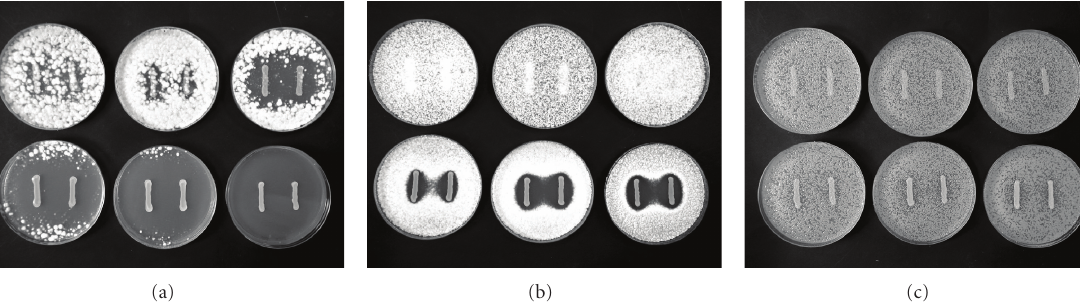
Figure 1: Antifungal overlay assay with P. freudenreichii subsp. freudenreichii against the molds P. commune (a), P. roqueforti (b), and the yeast R. mucilaginosa (c). Concentrations of glycerol in the overlaid agar are 0, 10, and 50mM in the upper row from left to right and 100, 200, and 500 mM in the lower row from left to right for each